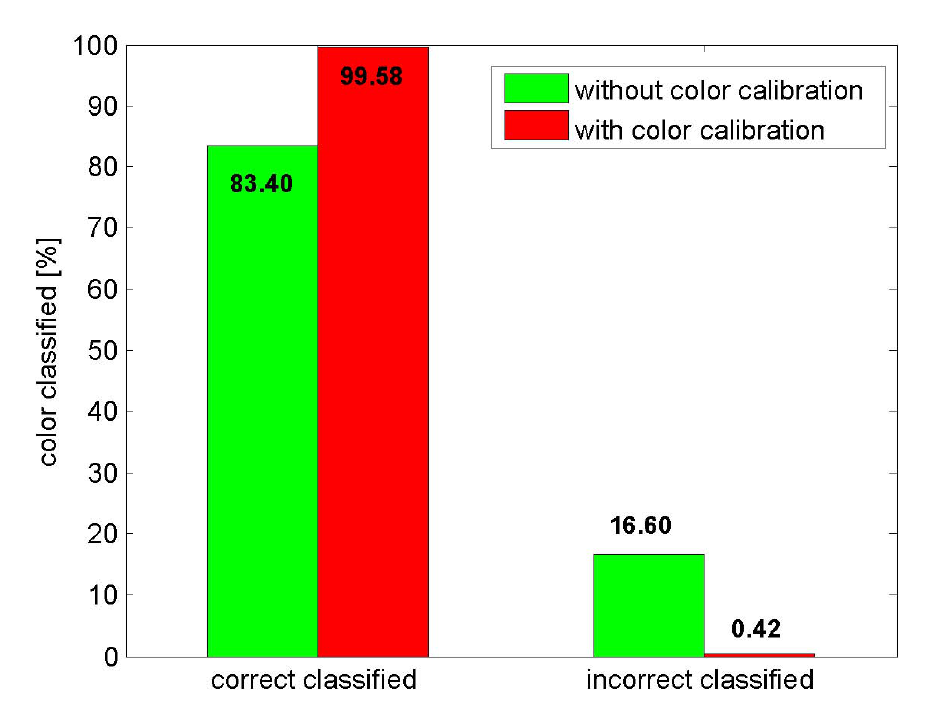
Figure 7. A comparison of color classification